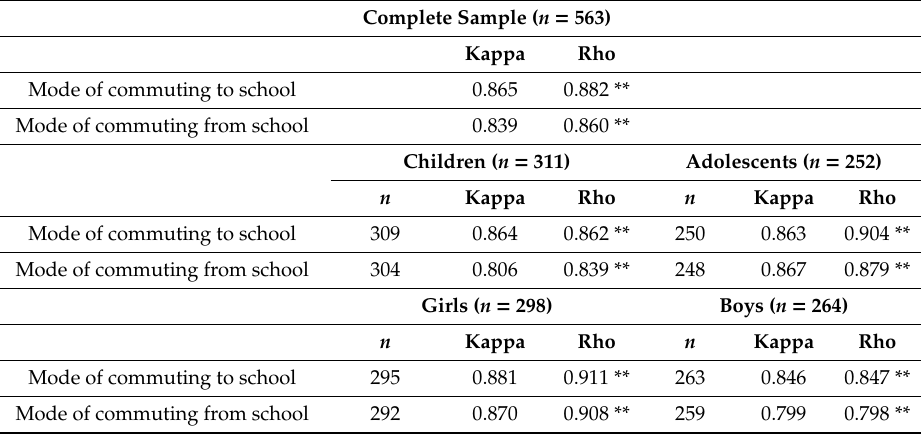
Table 3. Validation of the mode of commuting questions between parents and children.